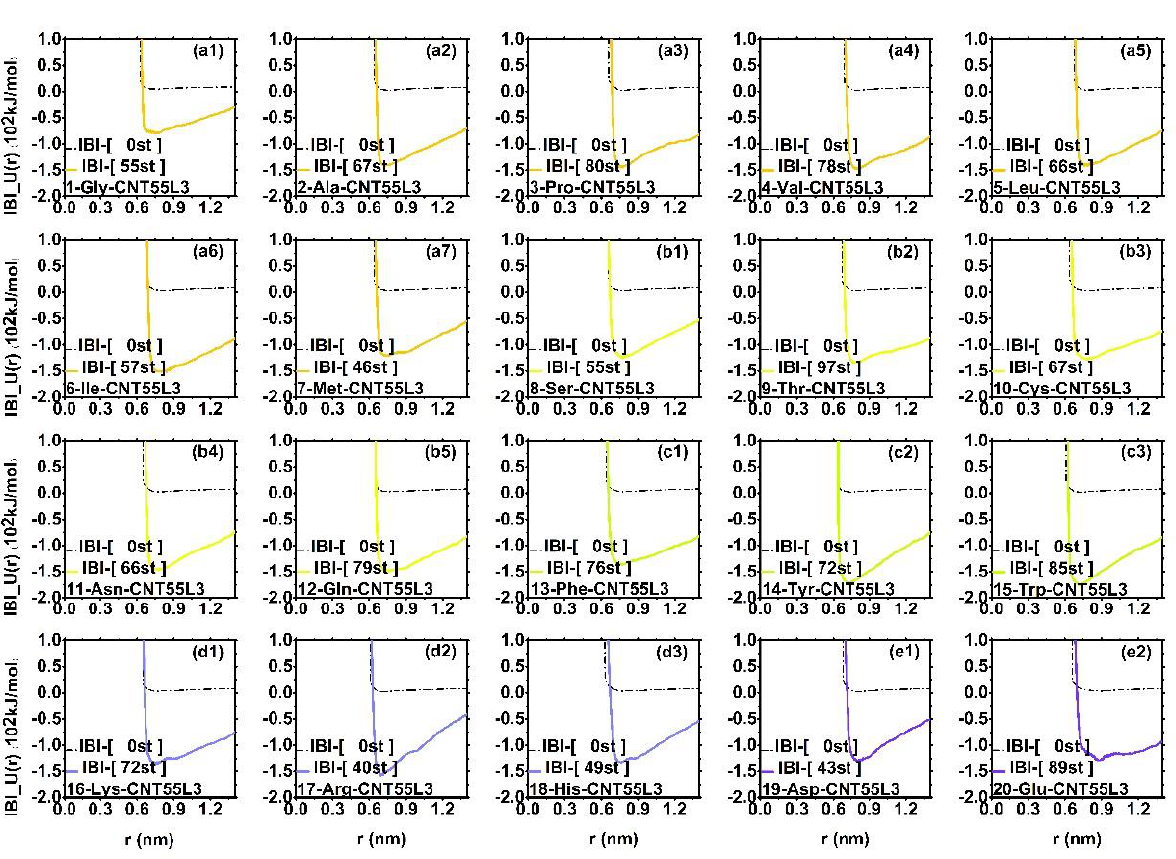
Figure 6. The non-bond potential energy function and initial non-bond potential energy function (PMF) between 20 amino acids and CNT55L3 obtained after IBI iterative optimization. The black dotted lines in each figure are their respective initial non-bond PMF, and ( a1 – a7 ) are the non-polar PMF of the amino acid group, the line color is orange; ( b1 – b5 ) is the non-bonding PMF of the polar uncharged amino acid group, the line color is yellow; ( c1 – c3 ) is the non-bond PMF of the aromatic amino acid group, the line color is green; ( d1 – d3 ) is the non-bonding PMF of the positively charged amino acid group, and the line color is blue; ( e1 , e2 ) is the non-bond PMF of the negatively charged amino acid group, and the line color is purple.